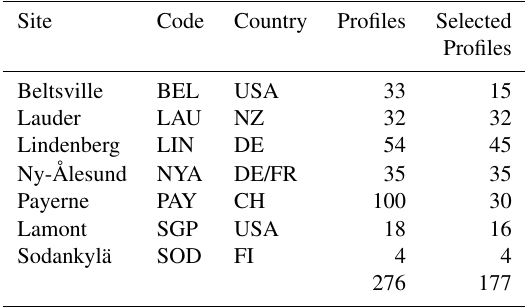
Table 1. GRUAN sites included in the Few_nan data set with the respective number of profiles and the number of profiles selected for the analysis, which have gaps shorter than 5s and a total of fewer then 10 missing